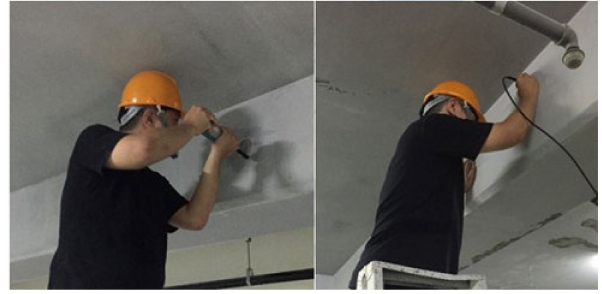
Figure 7. In-situ sample collection.